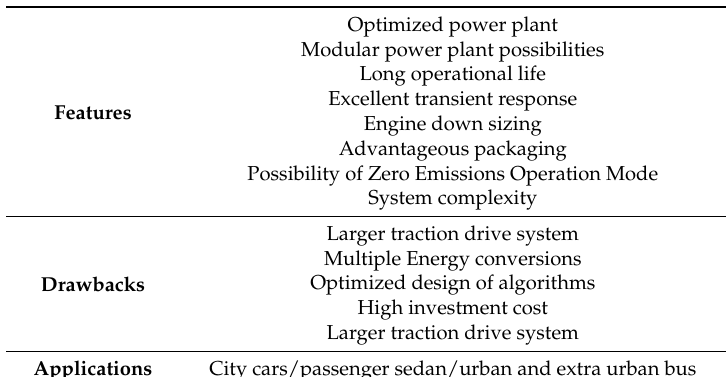
Table 3. Series Hybrid Specifications [4,5].